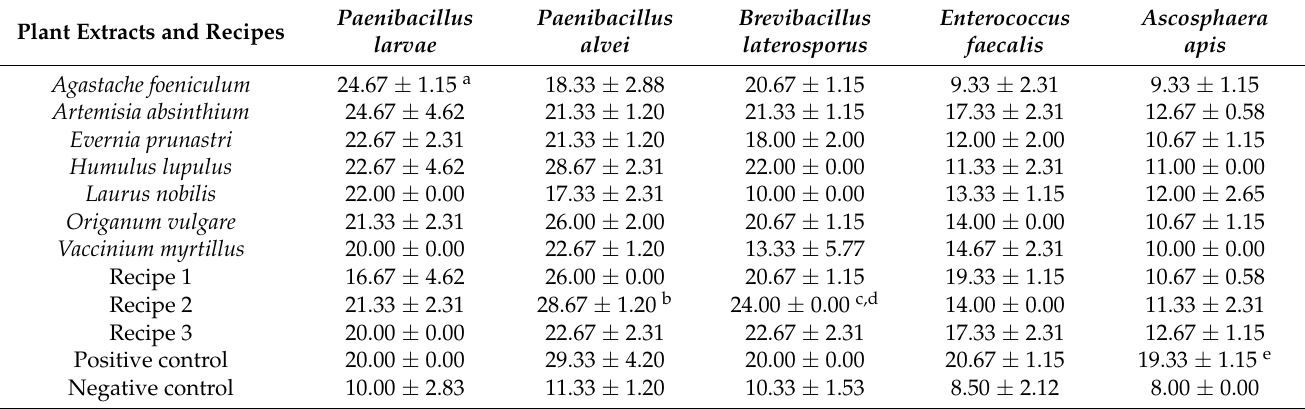
Table 4. Antimicrobial activity of plant extracts, recipes of medicinal products, negative (80% ethanol–solvent control) and positive (oxytetracycline) controls. Values are given in mm (zone of inhibition), as mean ± SD of triplicate measurements. Different superscript letters show significant differences, as explained